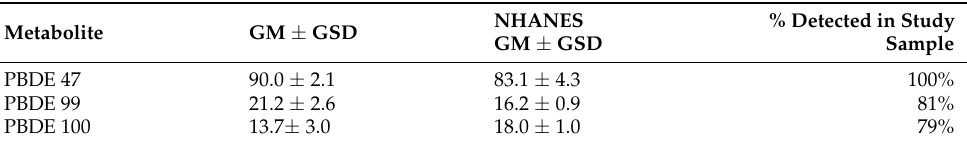
Table 3. PBDE metabolite serum concentrations (pg/mL) among African American women